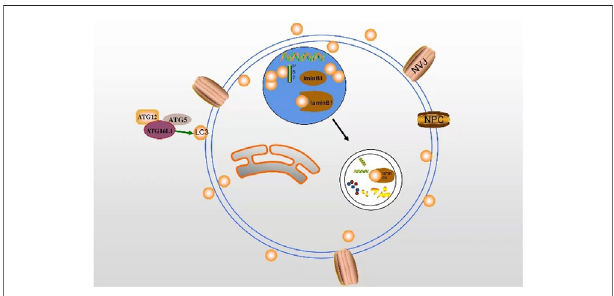
FIGURE 4 | The interaction between LC3 and lamin B1 may induce nuclear autophagy. LC3 transports autophagy membrane and substrate via binding to lamin B1 in the nucleus.